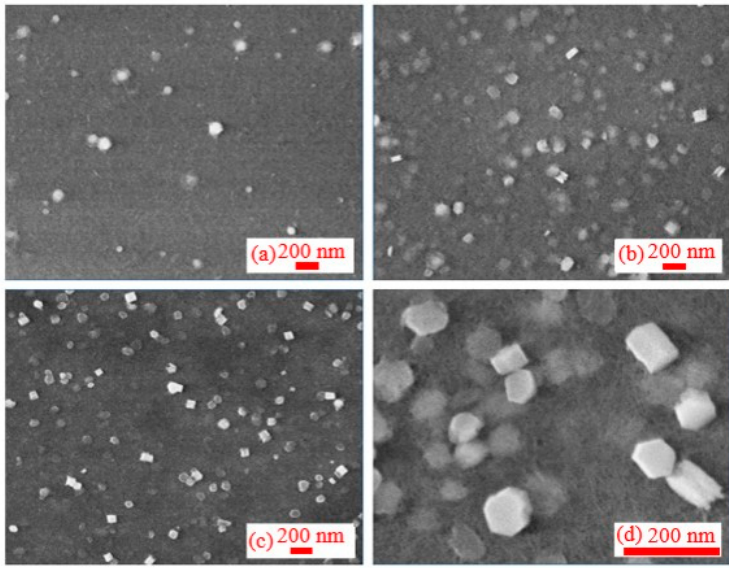
Figure 5. SEM images of NPs at different stages after ablation by 30 fs, 800 nm pulses: ( a ) within 1st day, ( b ) after 20 days, ( c ) after 40 days, and ( d ) after 80 days from ablation.